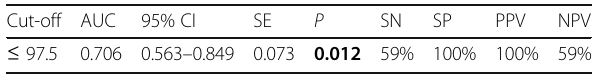
Table 2 ATX cut-off value to discriminate HCV from control: it showed that ATX ≤ 97.5 has 100% specificity in discriminating HCV and control but it is not sensitive